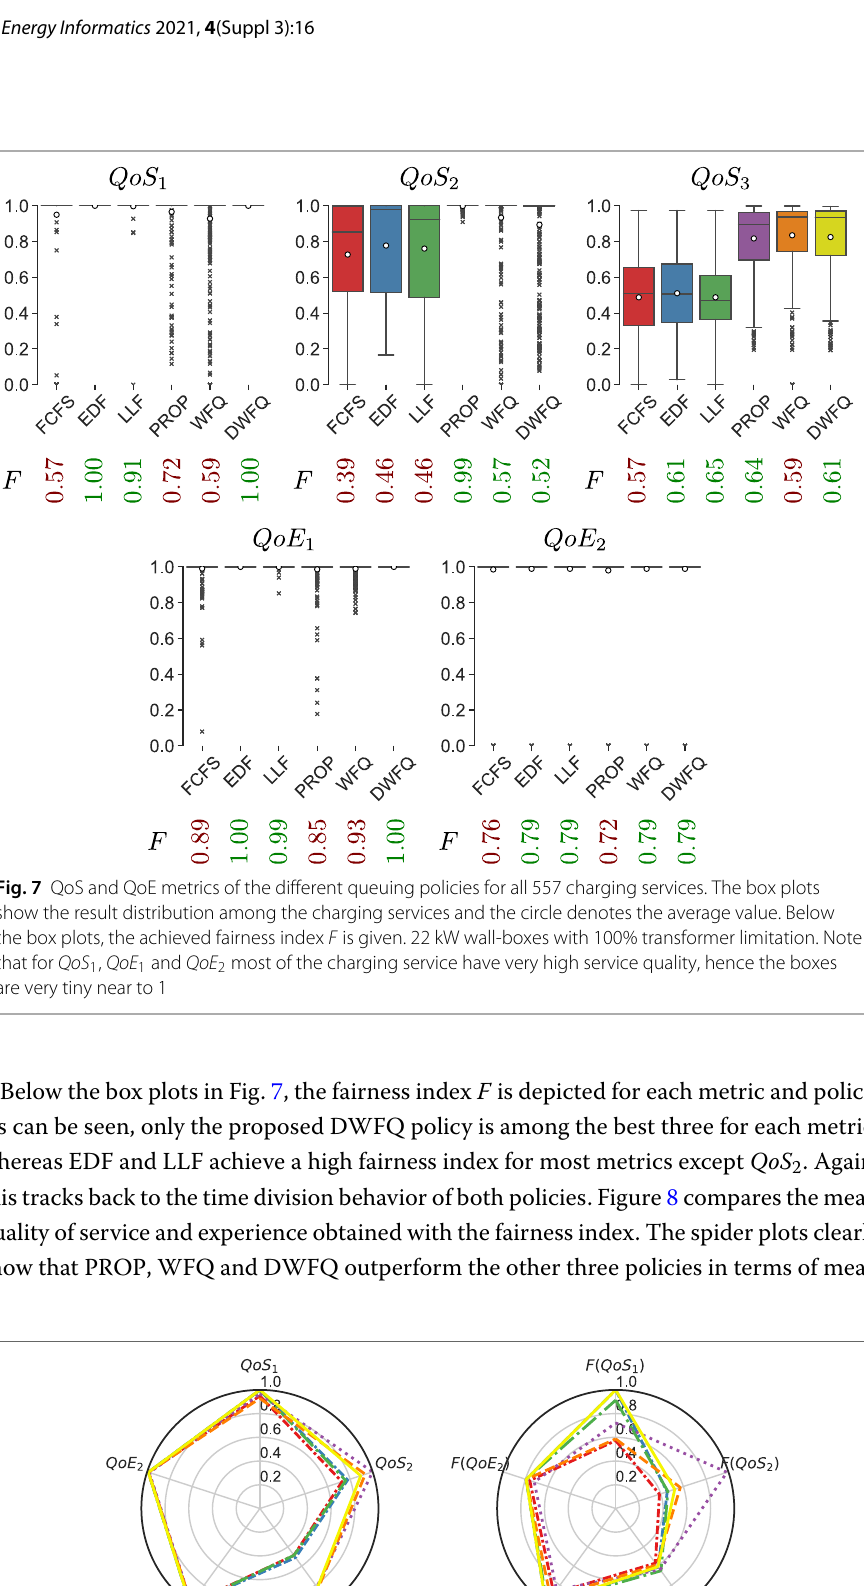
Fig. 8 Mean QoS and QoE metric values and fairness index of different queuing policies. 22 kW wall-boxes with 100% transformer